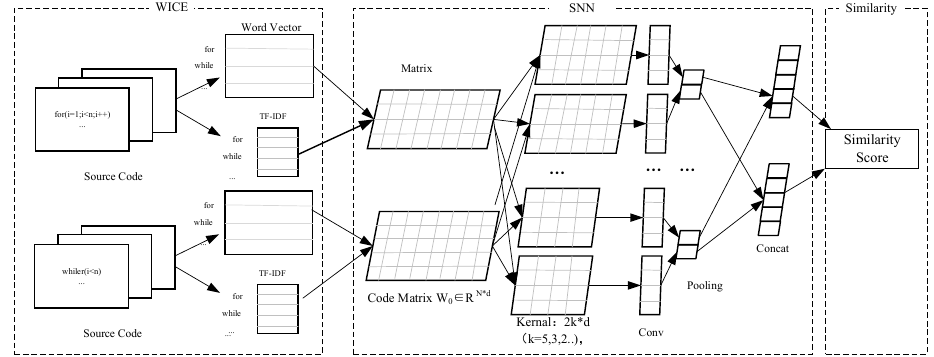
Figure 2. WICE-SNN Framework.